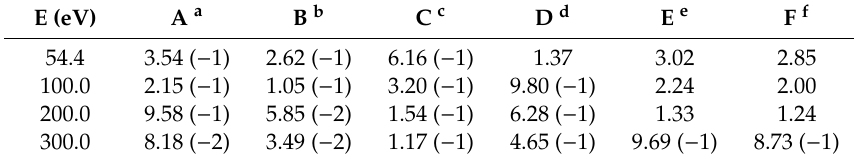
) and those obtained by 0